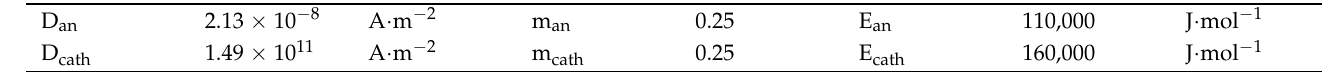
Table 5. Constants for activation resistances calculation [55].